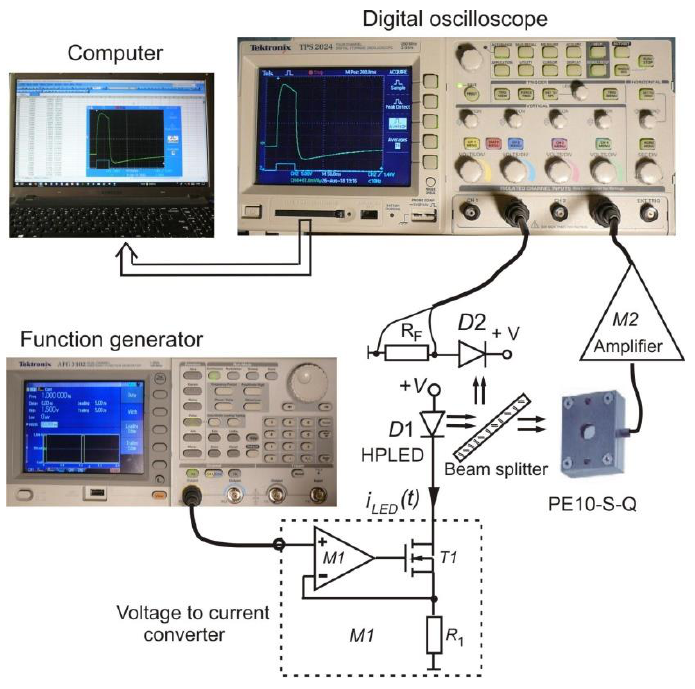
Figure 4. Block scheme of experimental setup employed for measurements of pyroelectric detector Figure response .